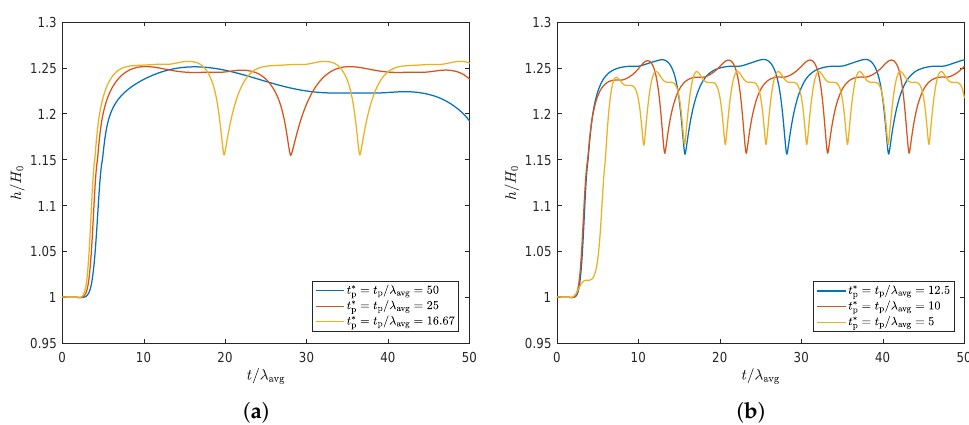
Figure 18. Swell ratio as a function of dimensionless time for the point of the free surface on Γ out , for a sinusoidal flow rate with dimensionless frequency f ∗ = 1/ t ∗ p , with t ∗ p = t p / λ avg .